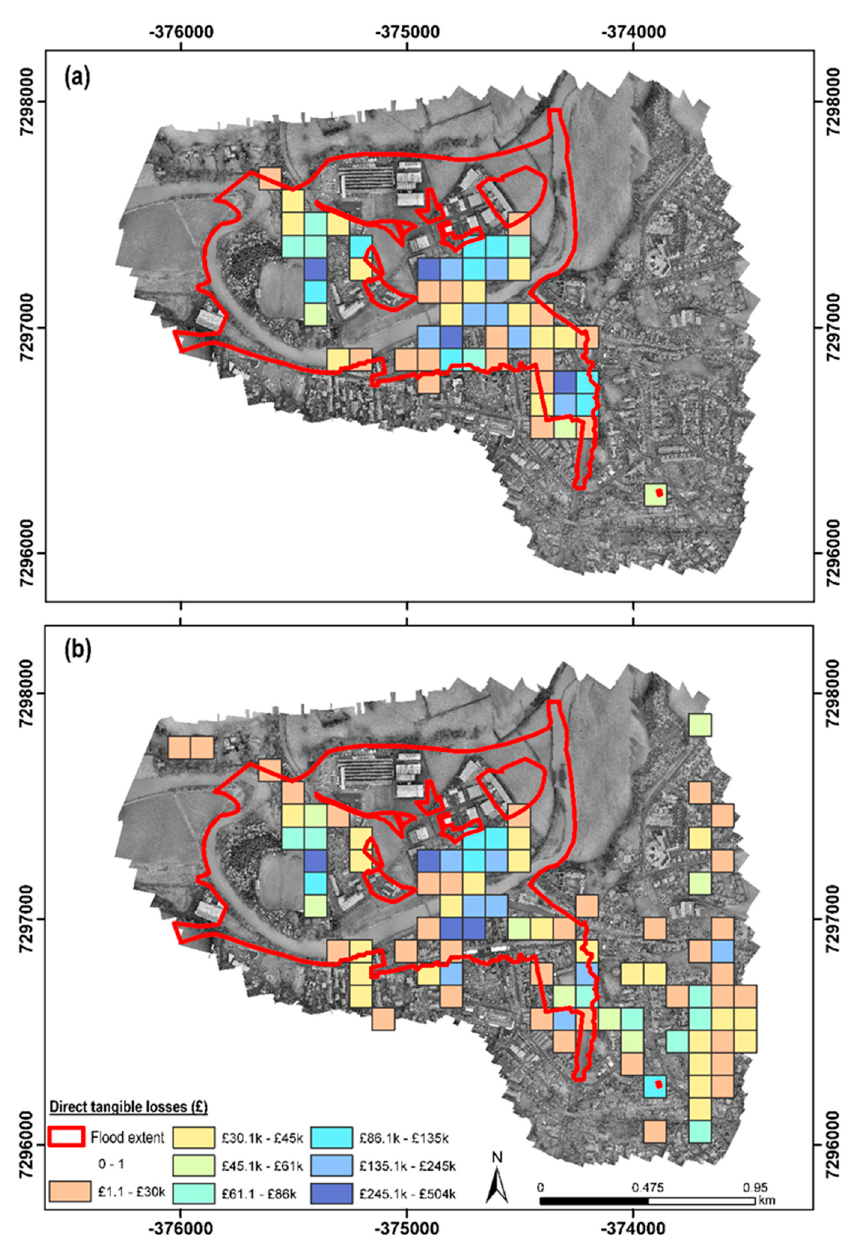
Figure 5. Estimated direct tangible losses (£) across Cockermouth following Desmond (5–6 December 2015) based on ( a ) the classic loss adjustment approach that relies on the Environment Agency fluvial flood extent and ( b ) the UAV loss adjustment approach. The methodology used for the estimation of the direct tangible losses was based on [31,32]. The losses (without VAT or other indirect taxes) are in GBP at 2016/17 prices. Calculations assume resilient/resistance measures were in place.